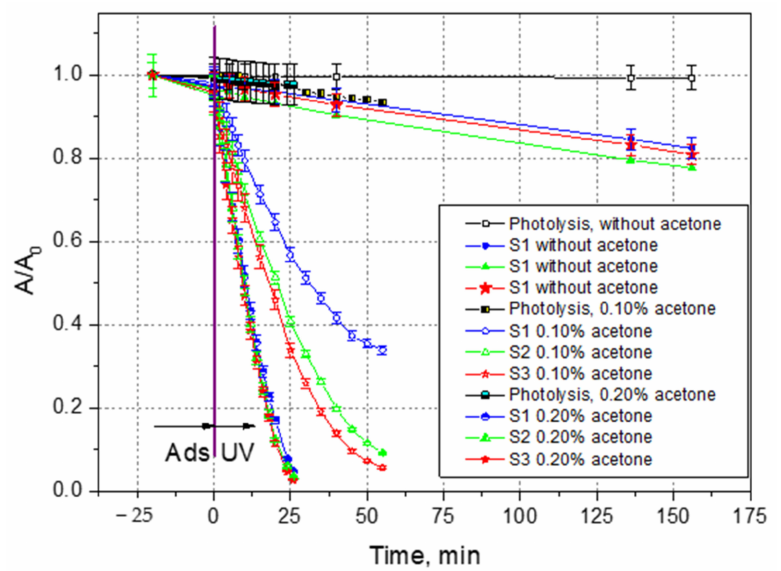
Figure 6. MB removal from the solution by photolysis (blank experiment), photocatalysis in the presence of S1, S2 and S3, and effect of acetone addition in the reaction system (4 ppm MB, 0.03 g L − 1